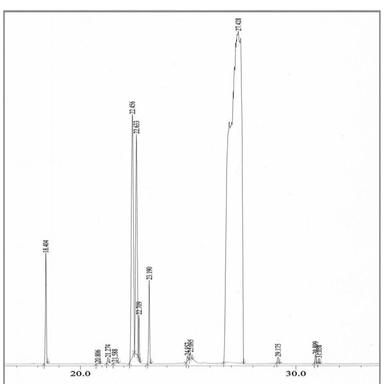
Profile of the different components of fatty acids found in crude Castor oil at different retention time by GC-MS spectrum.